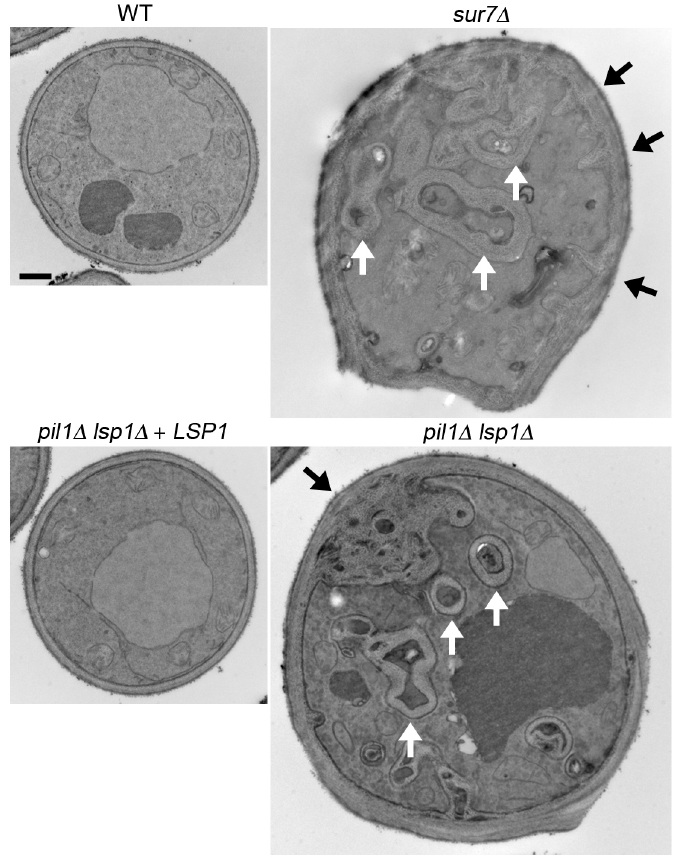
Figure 3. Abnormal cell wall invaginations in C. albicans sur7 ∆ and pil1 ∆ lsp1 ∆ mutants. The indicated cell sections were analyzed by transmission electron microscopy. Thicker cell walls and invaginations of cell wall material were detected in both the sur7 ∆ mutant and the pil1 ∆ lsp1 ∆ double mutant. The white arrows indicate tubes of cell wall material. Black arrows indicate spots where there are spiky invaginations in the sur7 ∆ mutant and the large round cell wall invagination in the pil1 ∆ lsp1 ∆ mutant. Black bar, 1 µm. This image was reproduced from Figure 2 of the paper by Wang et al. [19].